Question: State the chart type depicted above.
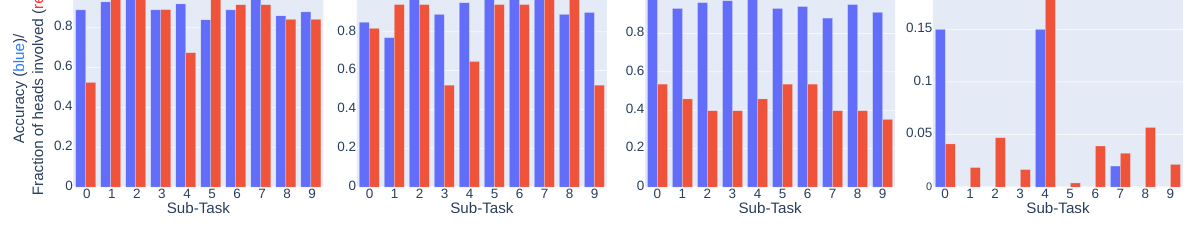
Answer: bar